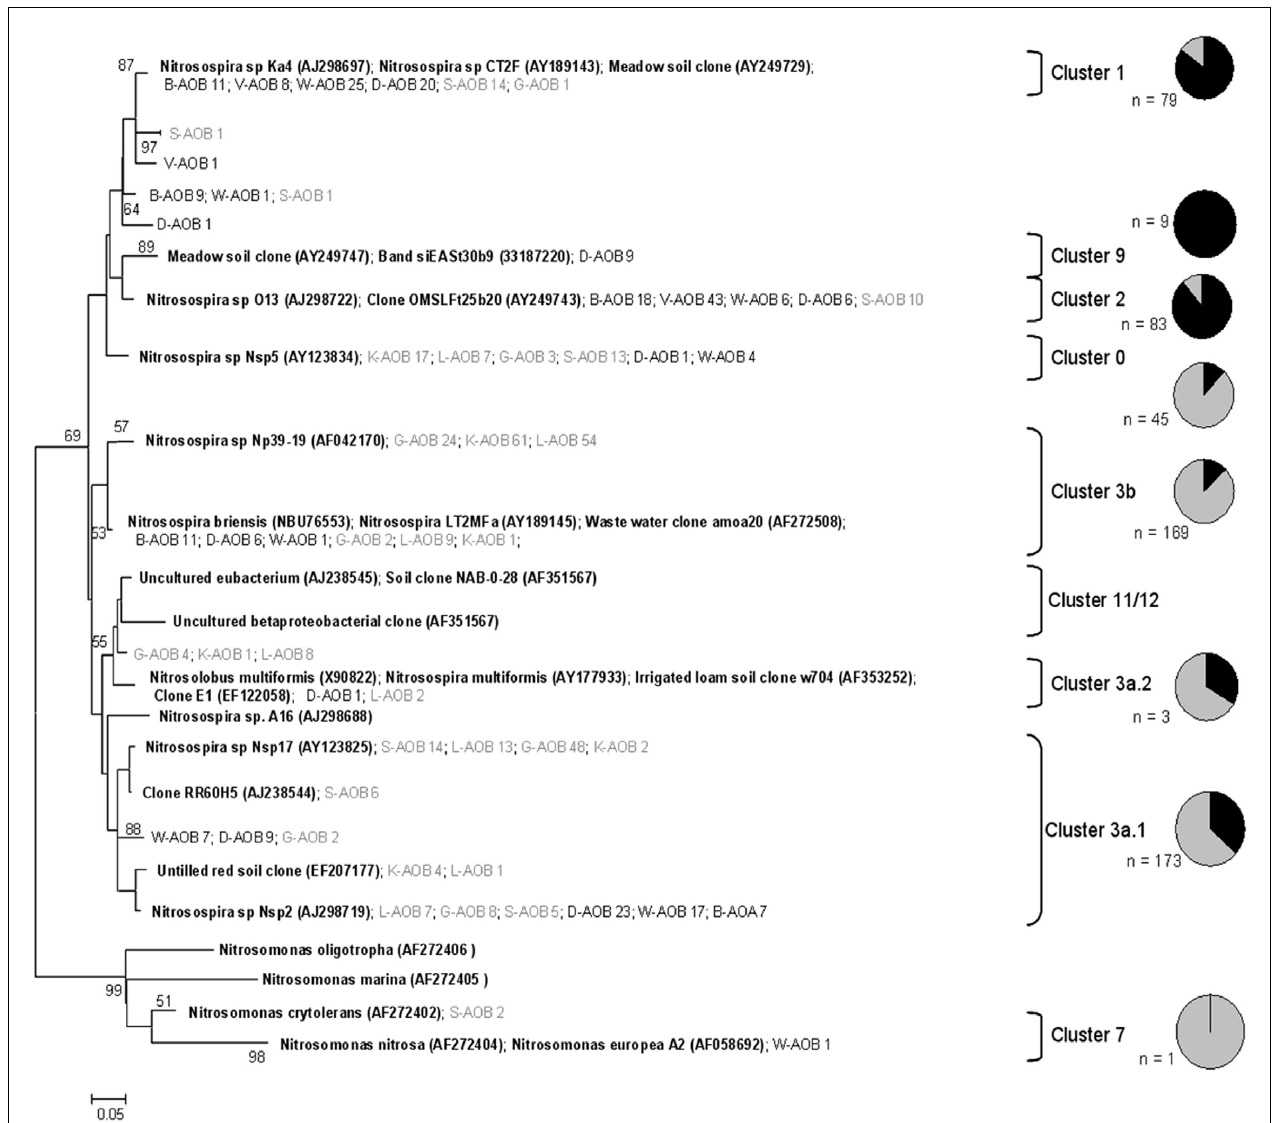
represent values from Neighbor-joining, using JTT substitution model (1000 replicates and 8 gamma rates; expressed as percentage). First letters represent the soil of origin followed by the number of clones found in that specific soil. Reference sequences are in bold described as “Name (accession number).”The tree was rooted with four sequences within the Nitrosomonas